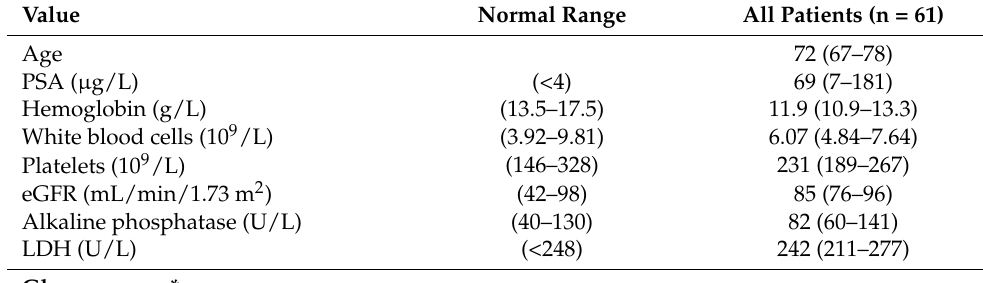
Table 1. Baseline characteristics of treated